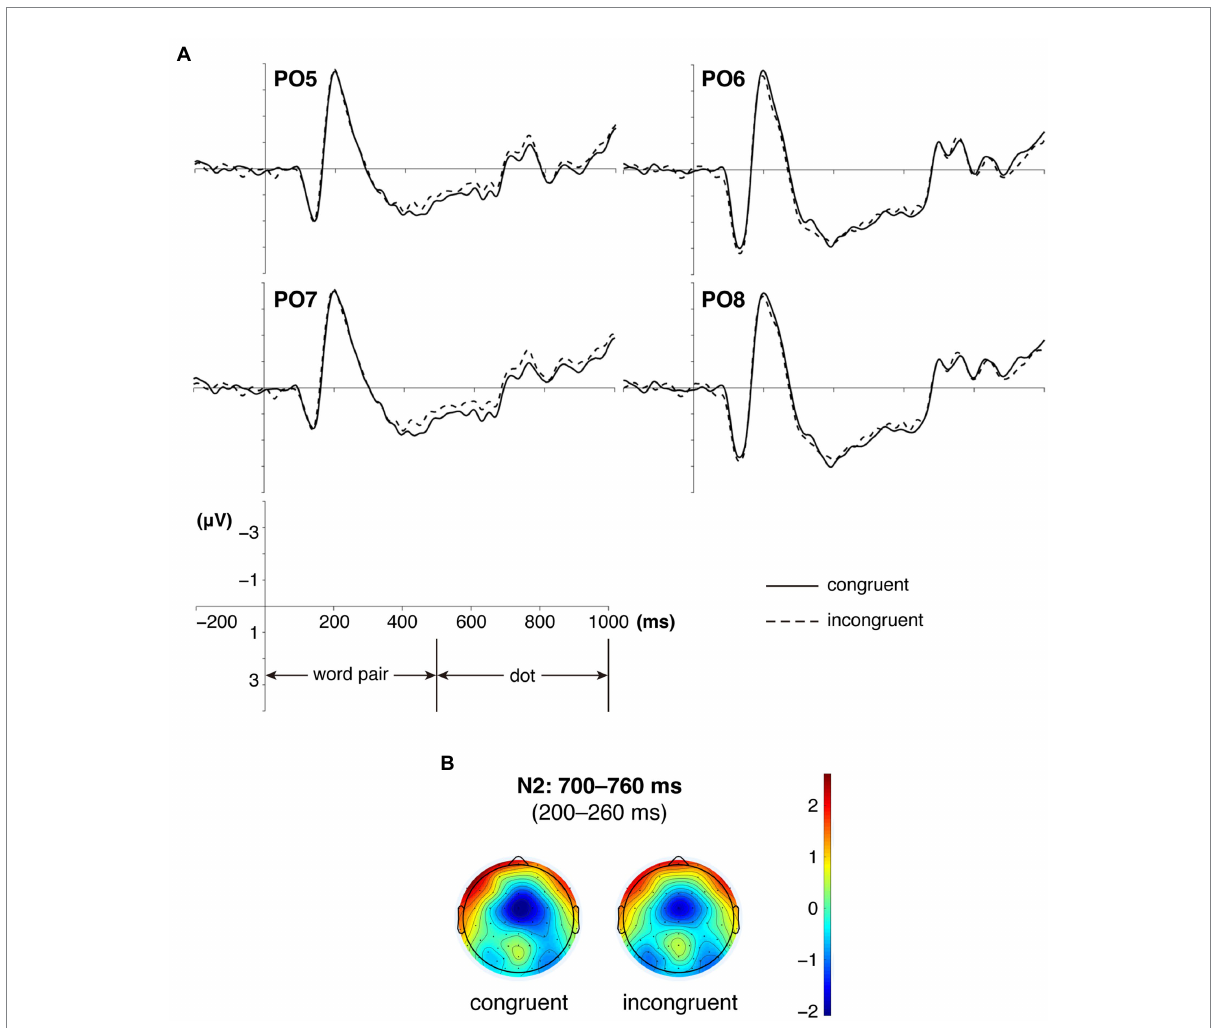
FIGURE 3 Mean grand-average ERPs (A) and the topography of cortical responses (B) to the dots under congruent and incongruent conditions over fronto- central and central sites for